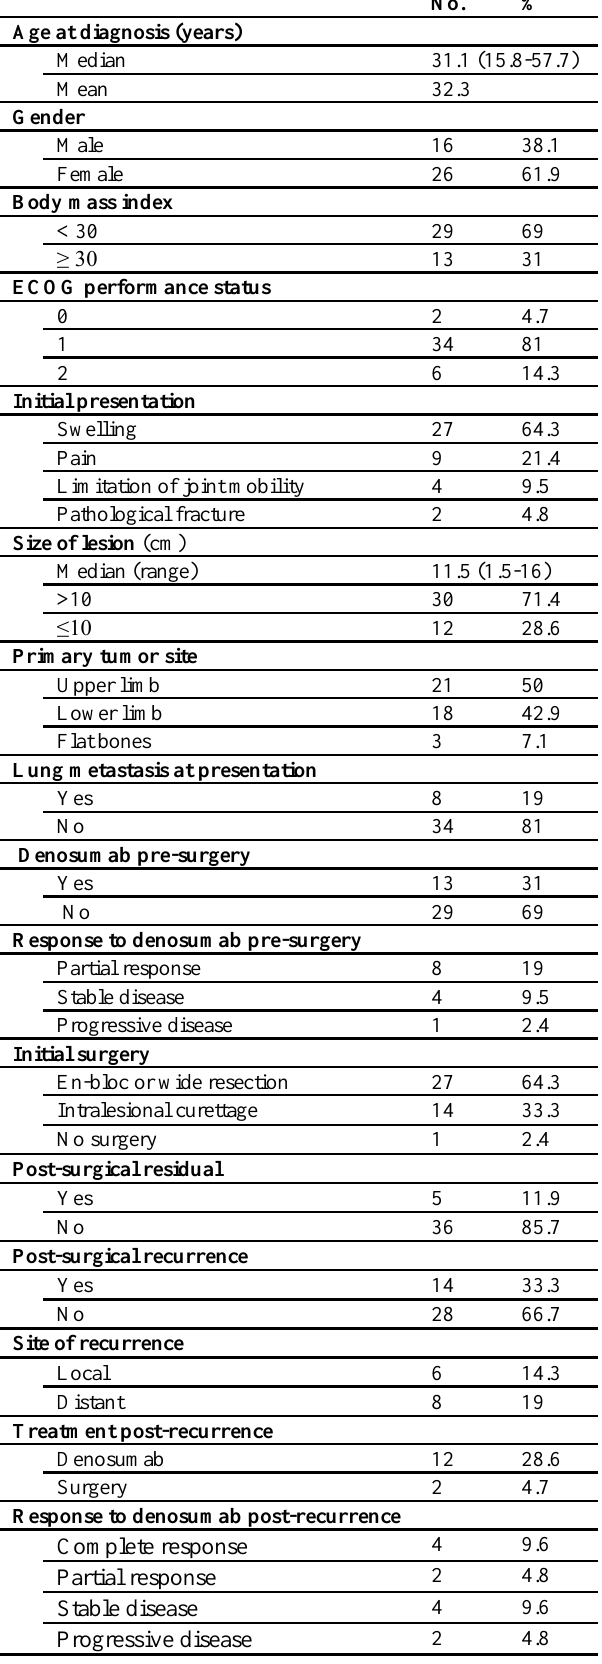
Table 1: Characteristics and treatment of 42 patients with giant cell tumor of bone